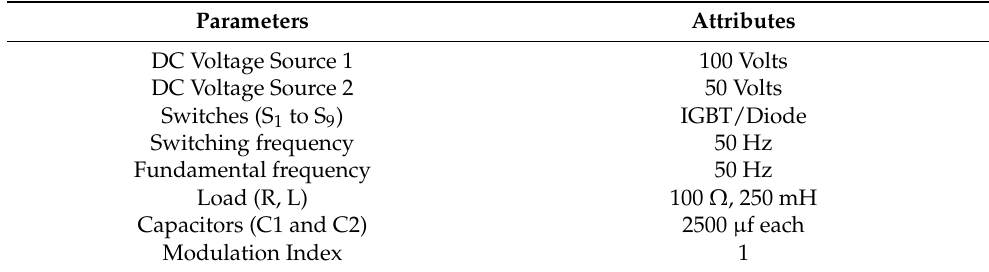
Table 4. Simulation parameters for the proposed FT MLI.